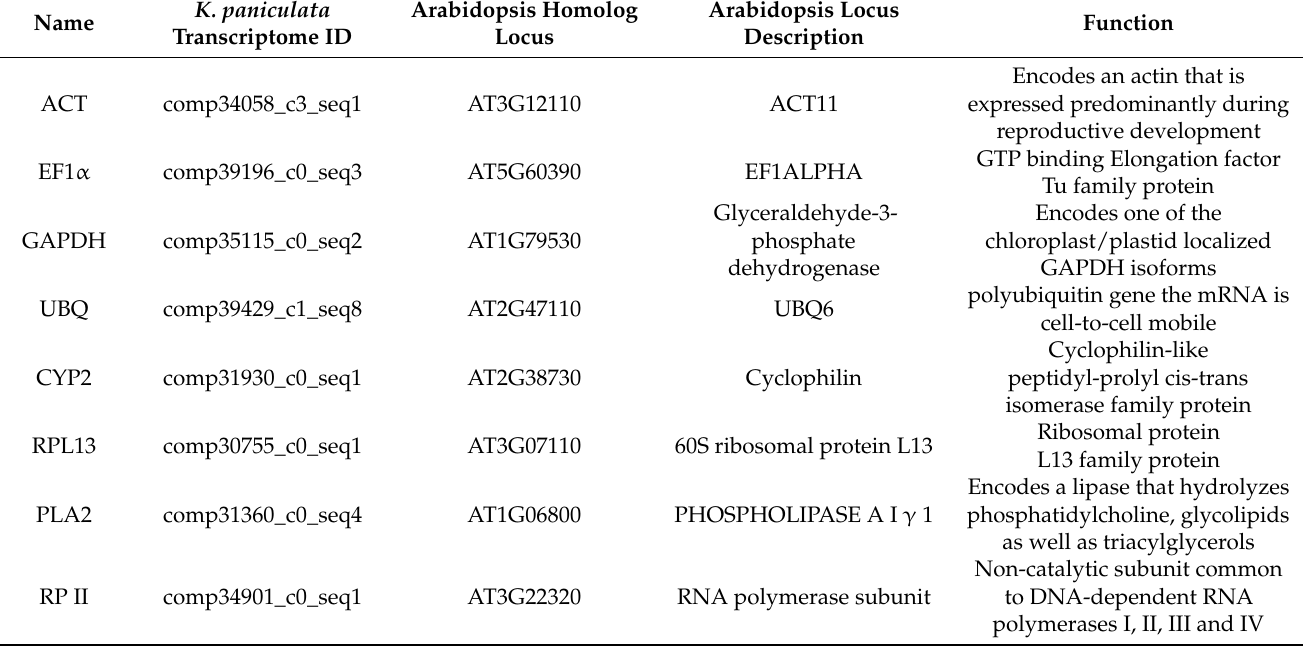
Table 1. Reference genes used for gene expression normalization in K. paniculate .